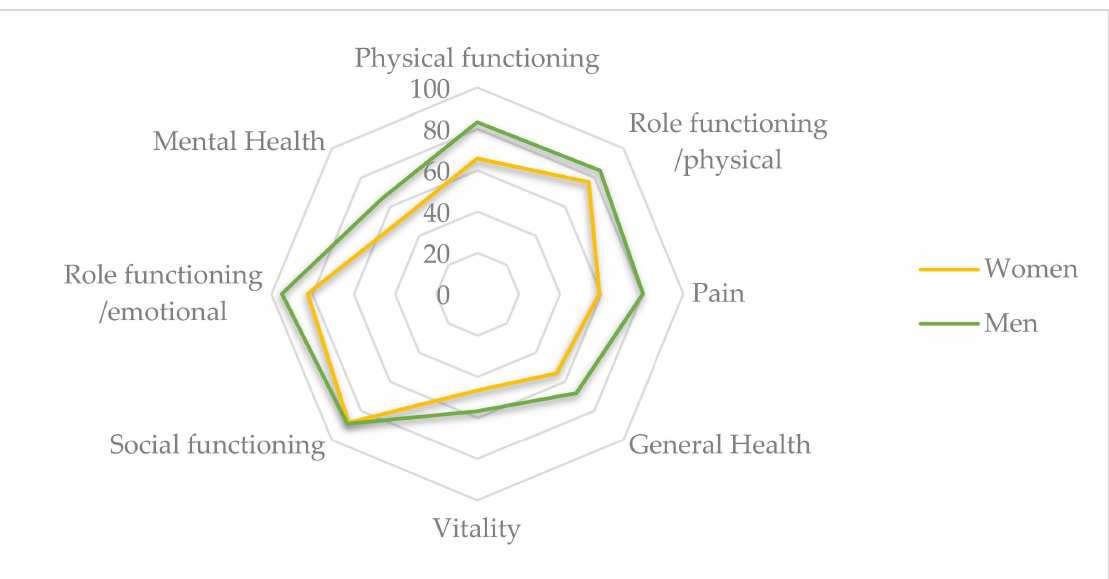
Figure 2. MOS-SF36 health-related quality of life dimensions: women vs.